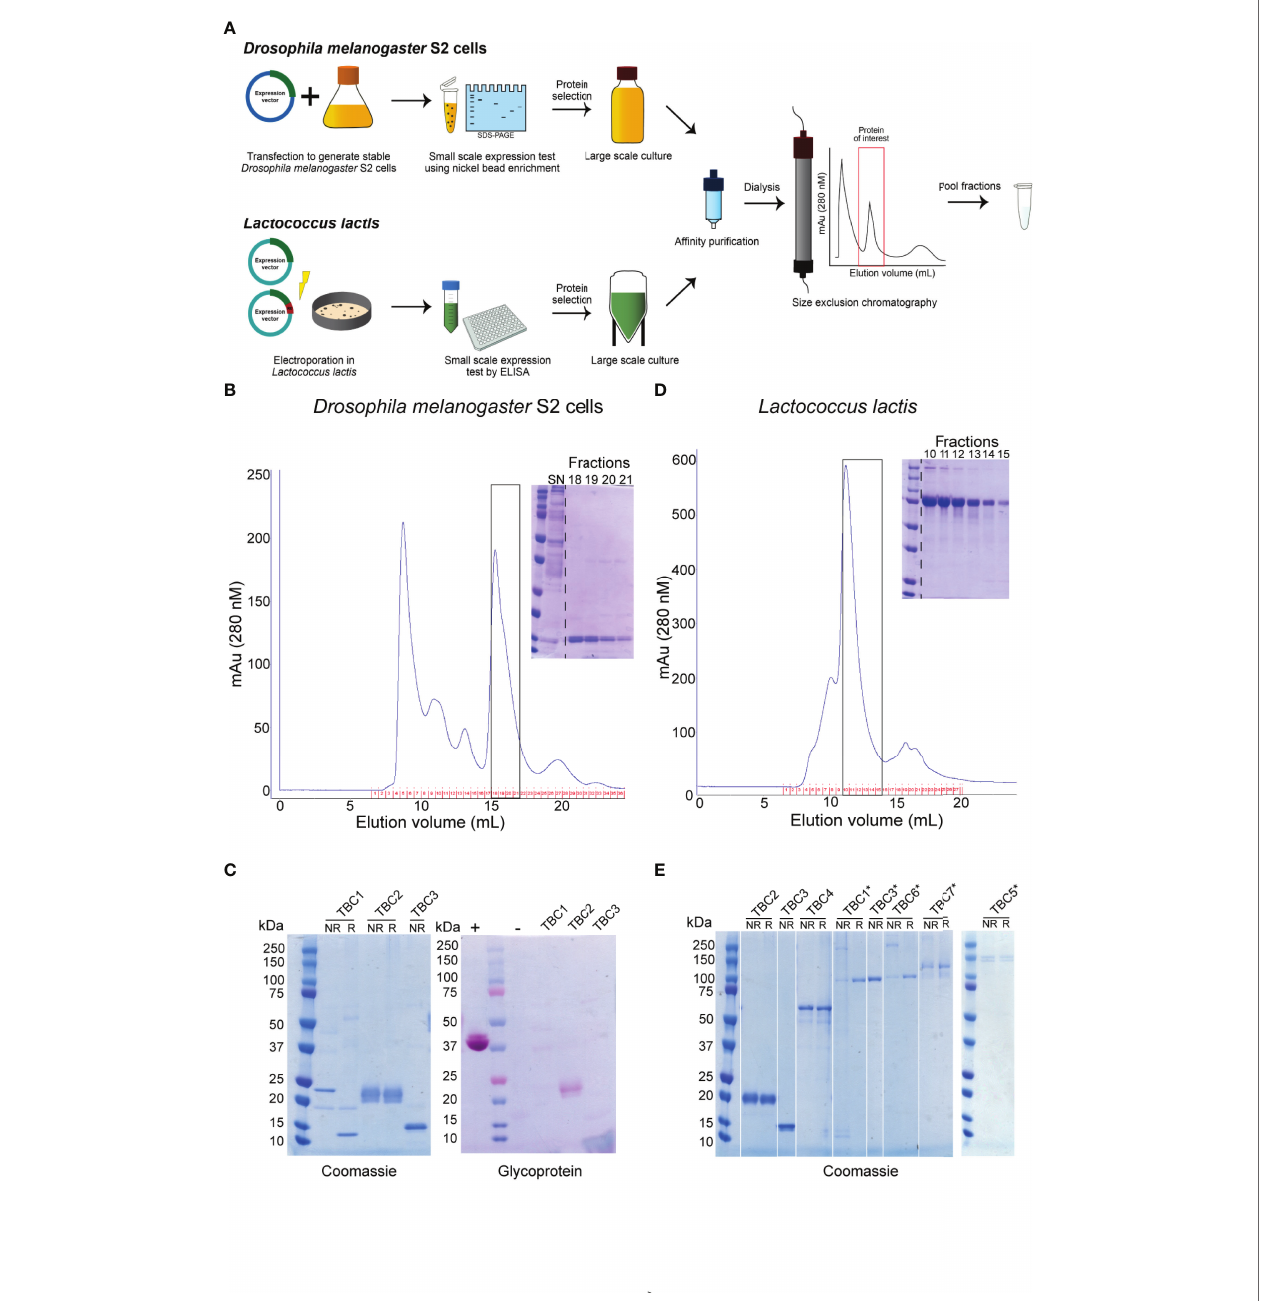
FIGURE 1 | Overview of recombinant protein puri fi cation and analysis. (A) Illustration of the expression and puri fi cation strategy of recombinant proteins. Representative puri fi cations on a Superdex 200 10/300 GL of a nickel-af fi nity puri fi ed protein expressed in (B) Drosophila melanogaster S2 cells or (D) Lactococcus lactis. Inset: Coomassie-stained non-reducing polyacrylamide gel of monomeric peak fractions. The puri fi ed proteins expressed in Drosophila melanogaster S2 cells (C) and Lactococcus lactis (E) were ran non-reduced (NR) and reduced (R) on a polyacrylamide gel and analyzed for purity using Coomassie-staining. Proteins expressed in S2 cells were also analyzed by glycoprotein staining (C) . *indicate antigens that were expressed as R0 chimeras. + and – indicate positive and negative controls, respectively. All antigens expressed as R0 chimeras run at a higher molecular weight, due to the glutamate content of